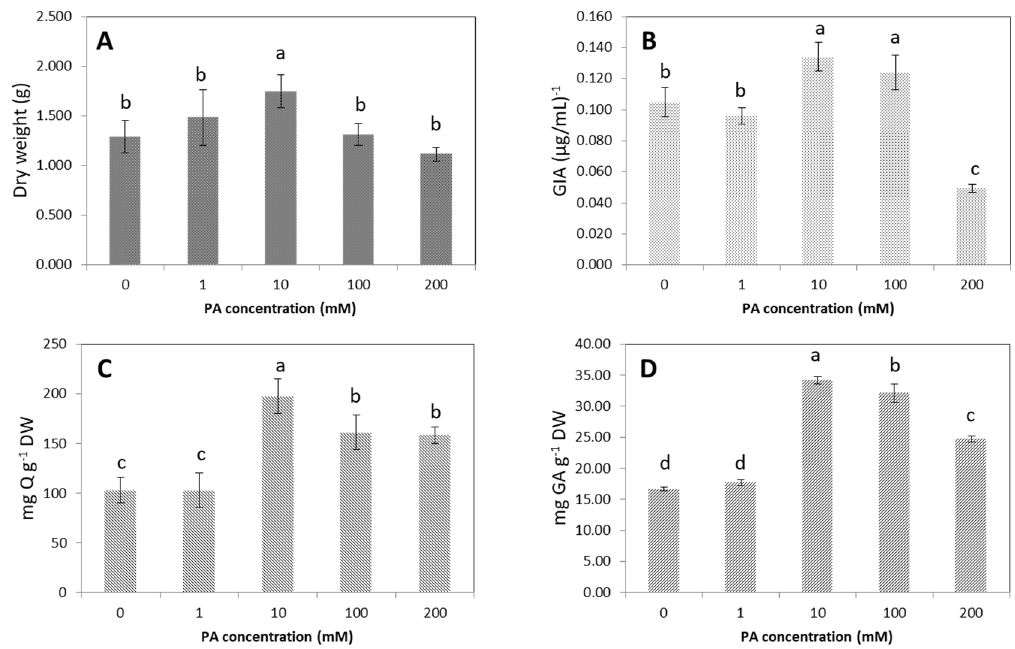
Figure 5. The effects of various phenylalanine (PA) concentrations on AHRs. ( A ) DW, ( B ) GIA, ( C ) FLA ( D ) PHEL. Error bars represent standard deviations. The values in one line marked with different lower-case letters denote significant differences between samples at p < 0.05 (Duncan’s multiple range test).